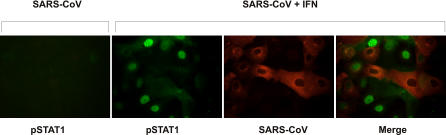
Inhibition of STAT1 Phosphorylation and Nuclear Translocation in SARS-CoV–Infected MA104 CellsMA104 cells were infected with SARS-CoV for 24 h and then either fixed directly (left panel) or treated with type I IFN and then fixed. Subsequently, cells were stained for phosphorylated STAT1 and SARS-CoV. The far right panel shows a merge of the two middle panels, showing an inhibition of STAT1 phosphorylation and translocation in SARS-CoV–infected cells.